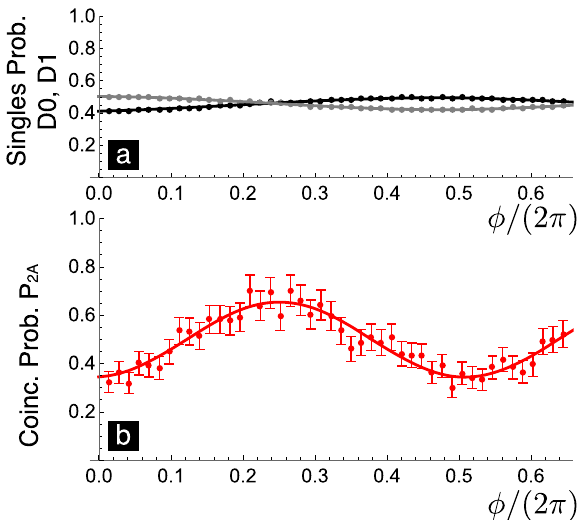
Fig. 4 Single and coincidence count probabilities at detectors D0 and D1 when the phase in the corresponding 2 × 2 interferometer is varied over time. a Single count probabilities. b The coincidence counts show the double frequency corresponding to self- interference of a two-photon wavepacket. Error bars correspond to Poissonian count